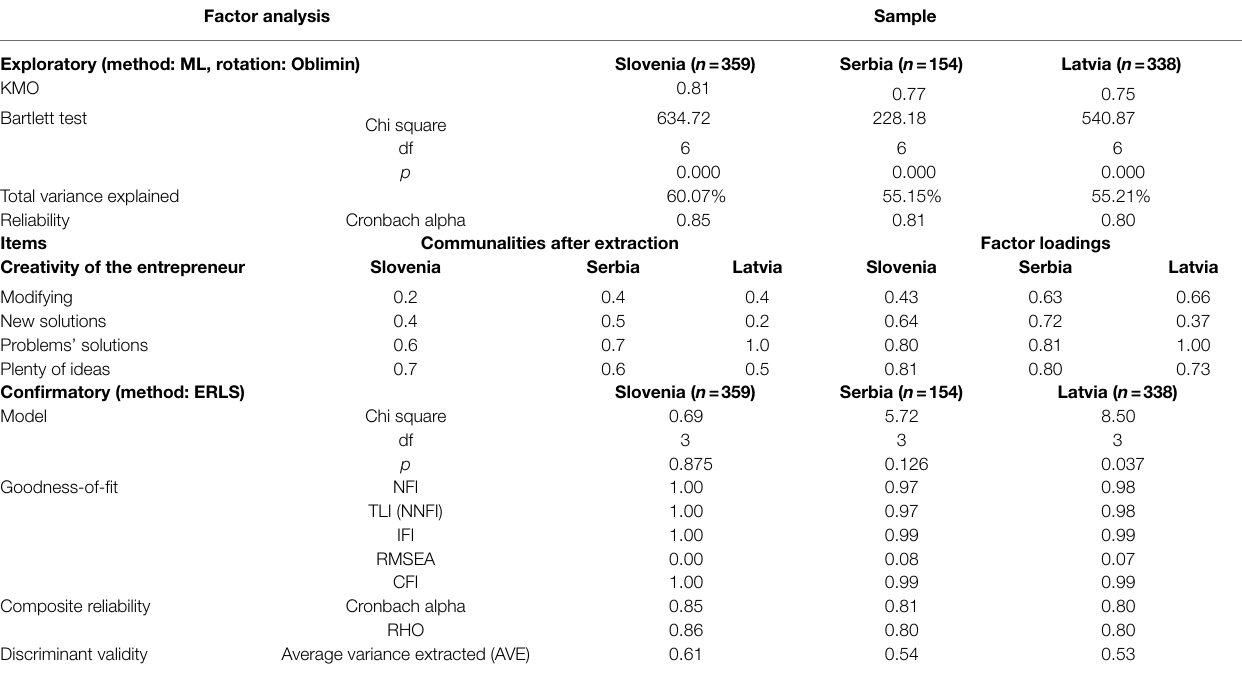
TABLE 3 | The creativity of the entrepreneur construct—factor analysis results. Factor analysis